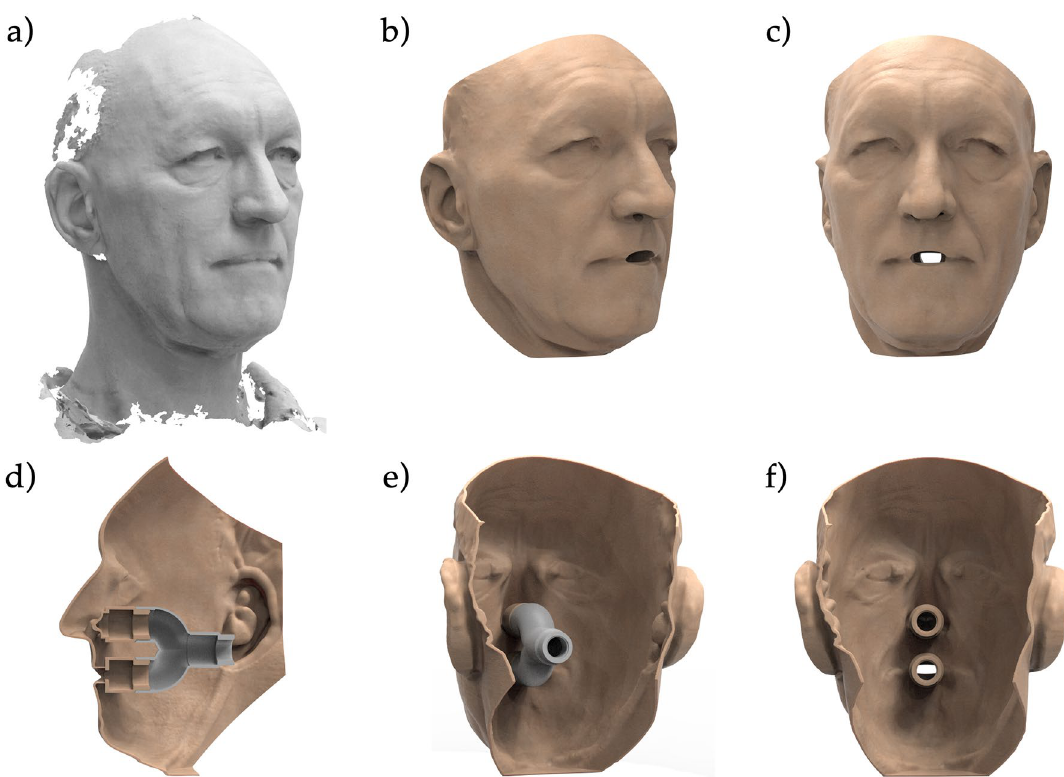
Figure 3. Practitioner’s face scan (a) and one test face design with added holes in the nose and mouth (b,c) . A tube system and an adaptor were designed and printed for connection to the pump (d–f)